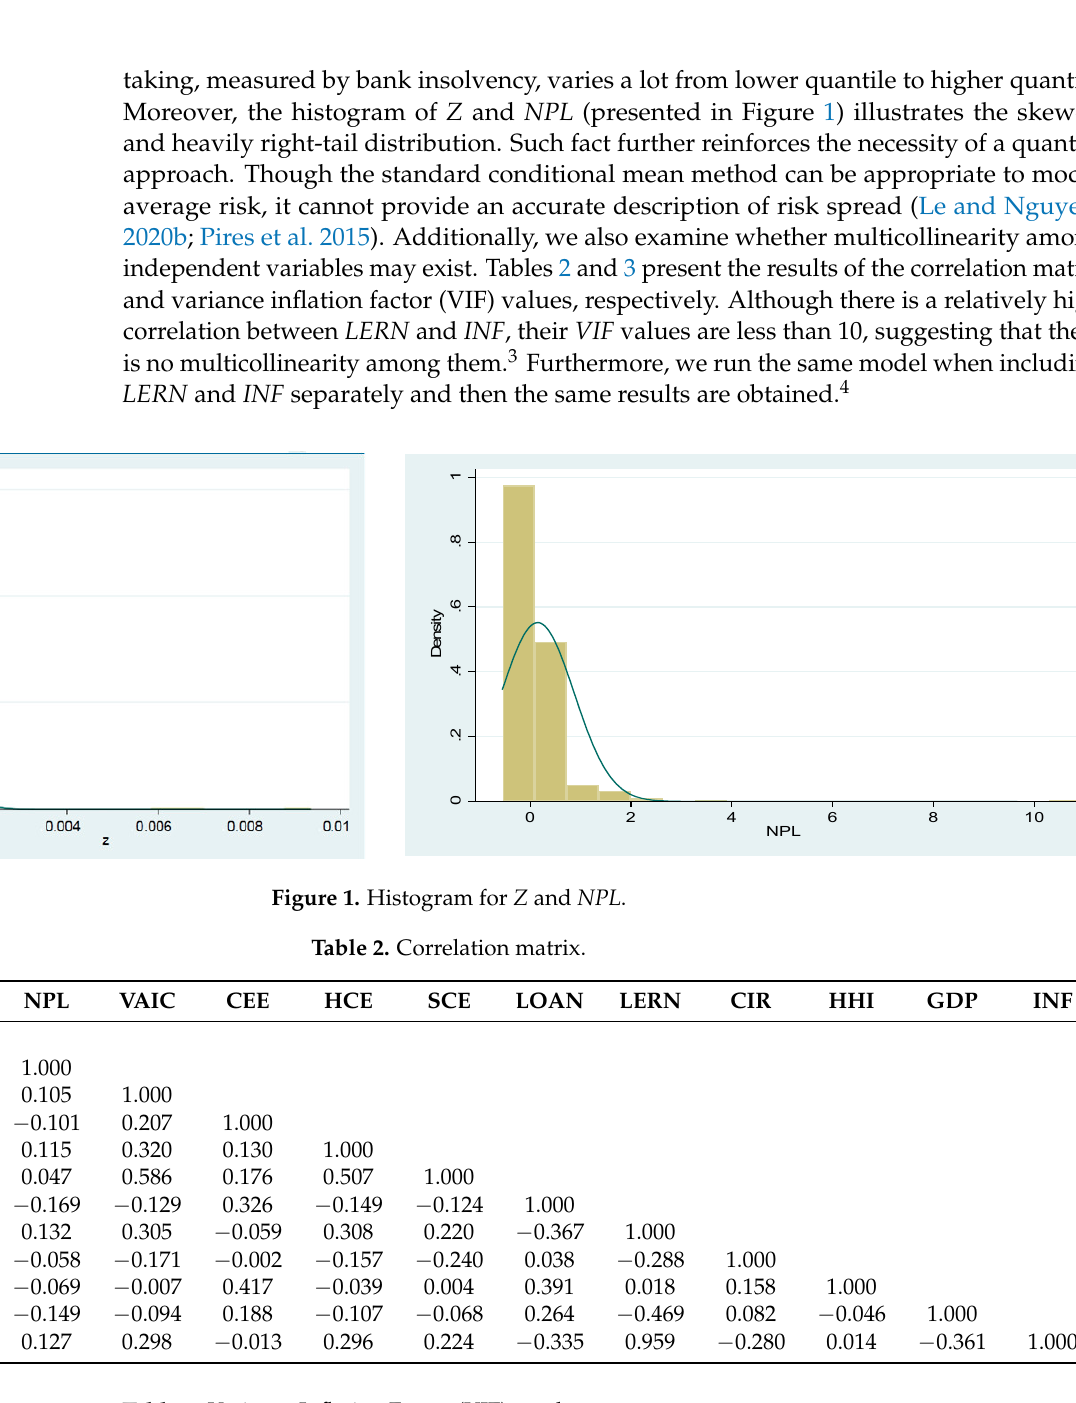
Table 3. Variance Inflation Factor (VIF)